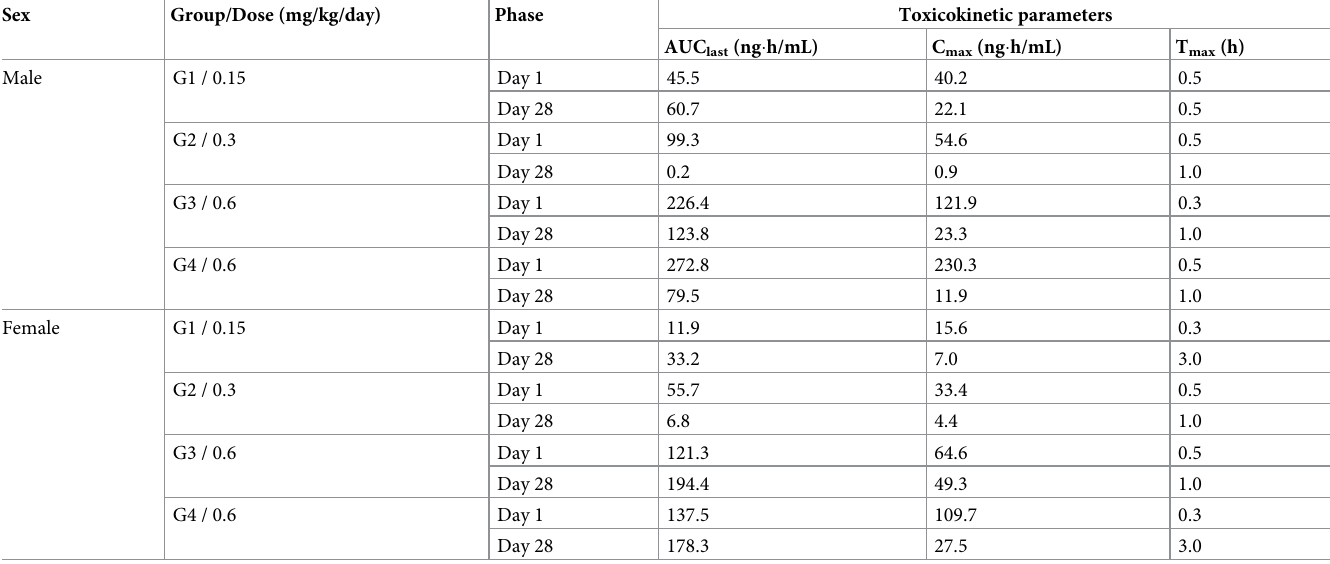
Table 6. Toxicokinetic parameters of CGH942 and Genotropin in rats. Sex Group/Dose (mg/kg/day) Phase Toxicokinetic